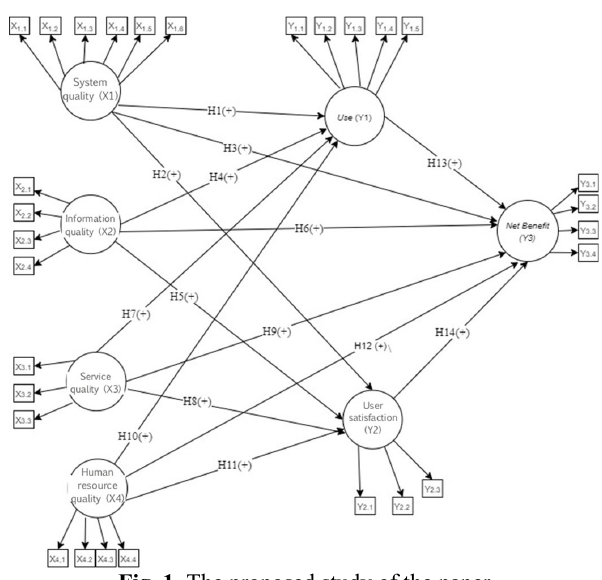
Fig. 1. The proposed study of the